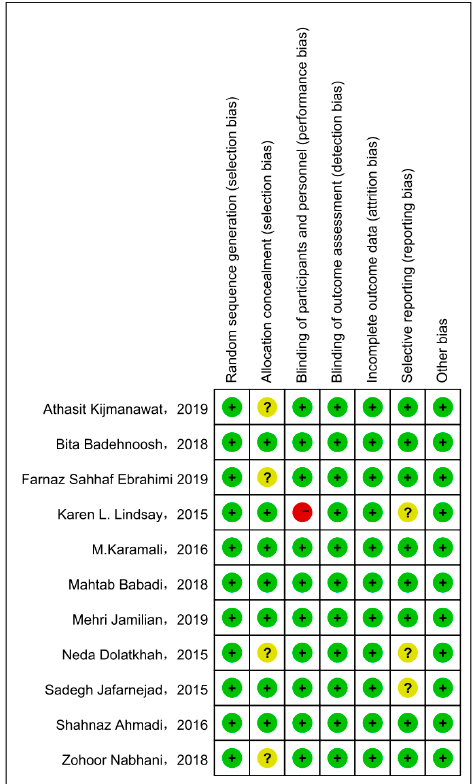
Figure 3. The concrete bias of each study.